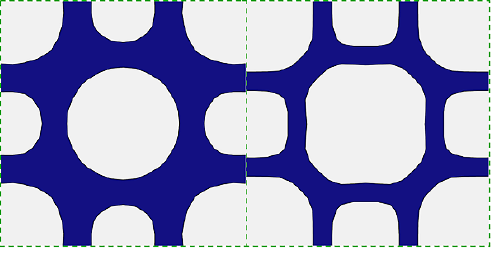
Figure 1. C 0 connectivity in FGM.